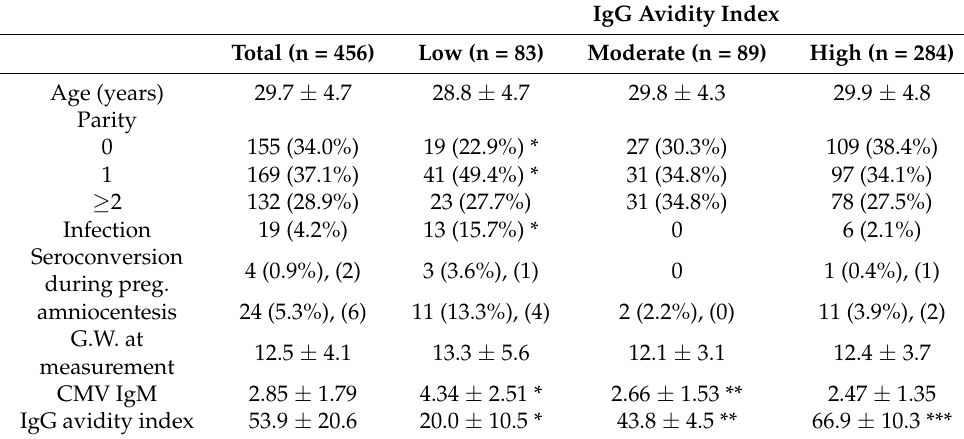
Table 1. Characteristics of the pregnant women according to IgG avidity